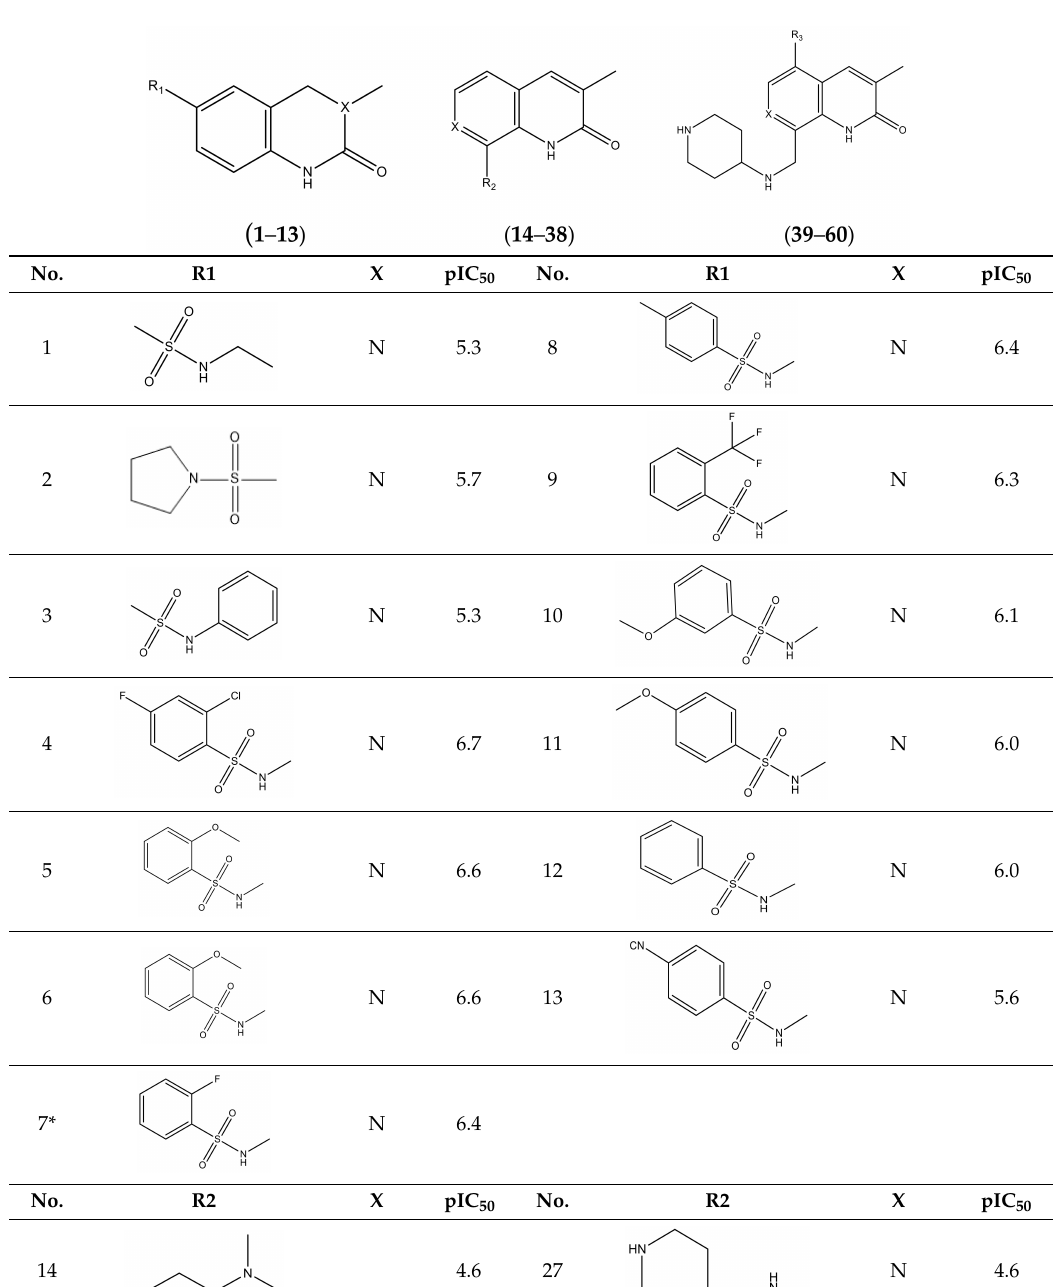
Table 4. Structures of the BRD4 inhibitors and their biological